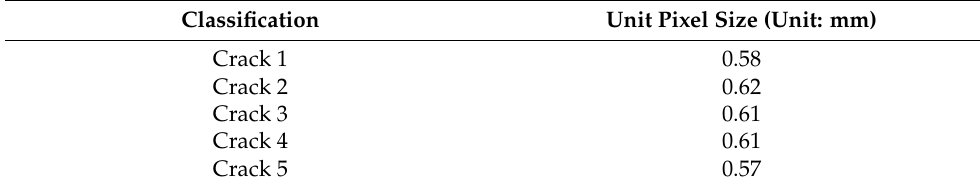
Table 2. Unit pixel size calculated for each analysis data.